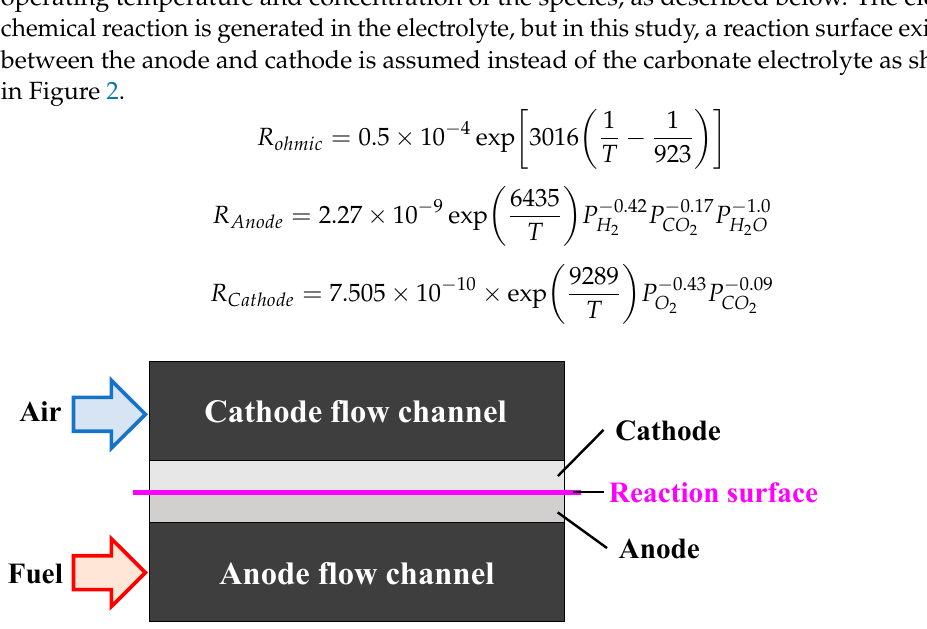
Figure 2. Schematic diagram of the reaction surface in MCFCs.